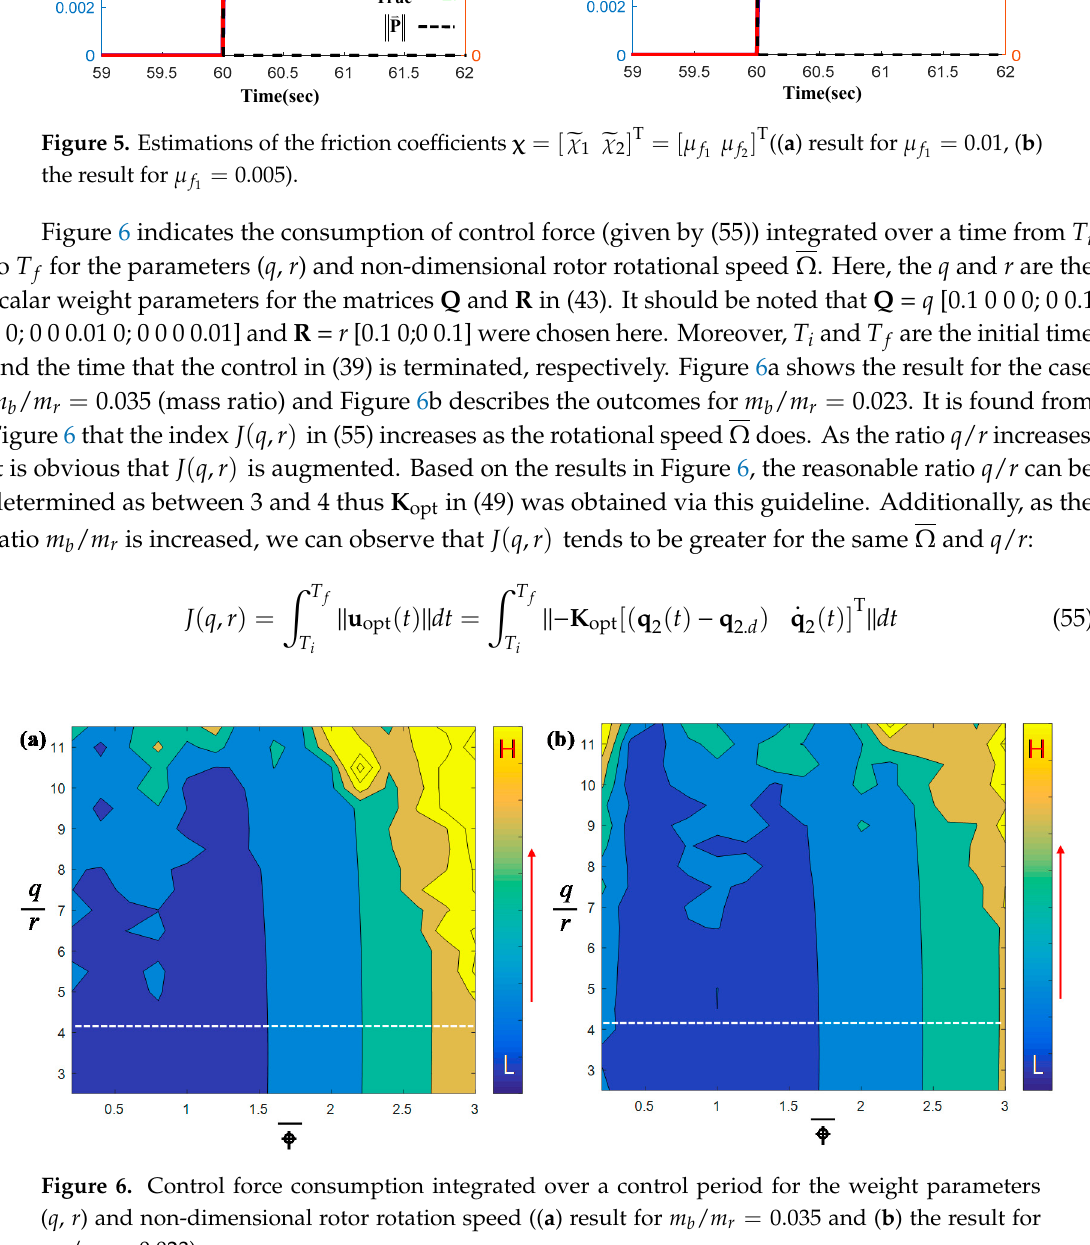
mm and ( b ) the result for rb